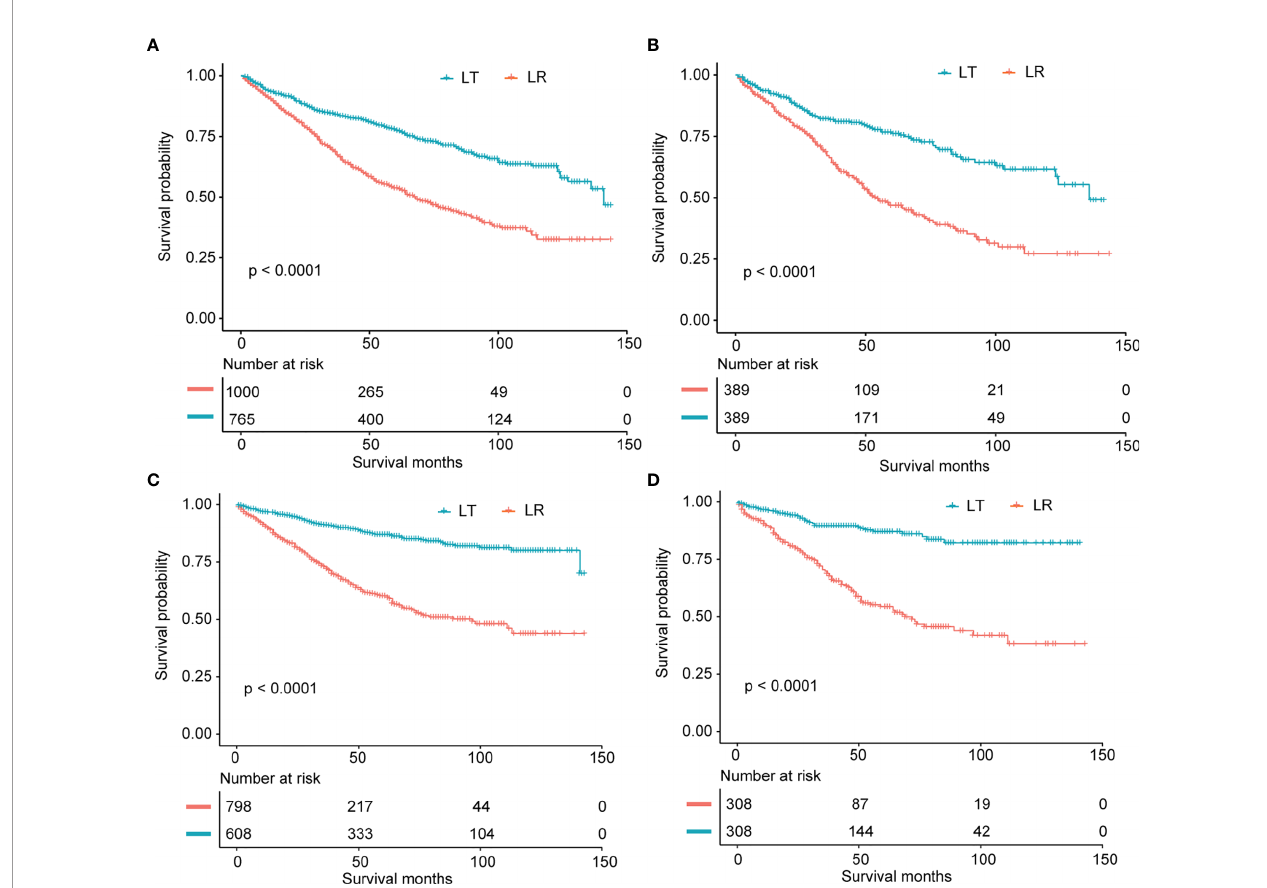
FIGURE 3 | (A) Overall survival analysis for patients who underwent LR and LT in non-adjusted population. (B) Overall survival analysis for patients after LR and LT in propensity score matched cohort. (C) Disease-speci fi c survival analysis for cases receiving LR and LT in non-adjusted cohort. (D) Disease-speci fi c survival analysis for cases after LR and LT in propensity score matched